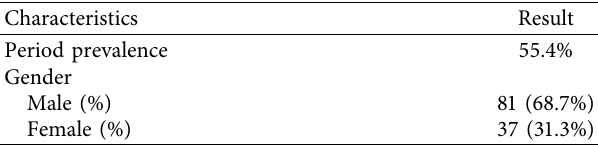
Table 2: Characteristics of RT-PCR confirmed COVID-19